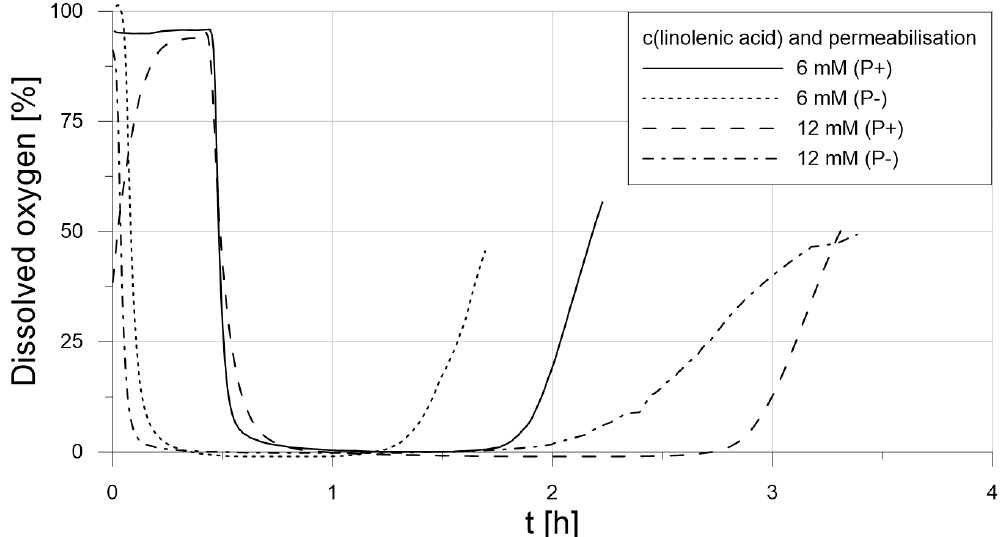
Figure 3. Oxygen monitoring during the synthesis of hydroperoxides by E. coli BL21(DE3) expressing LOX (P+ with permeabilization, P ‐ without permeabilization (see 3.5)).